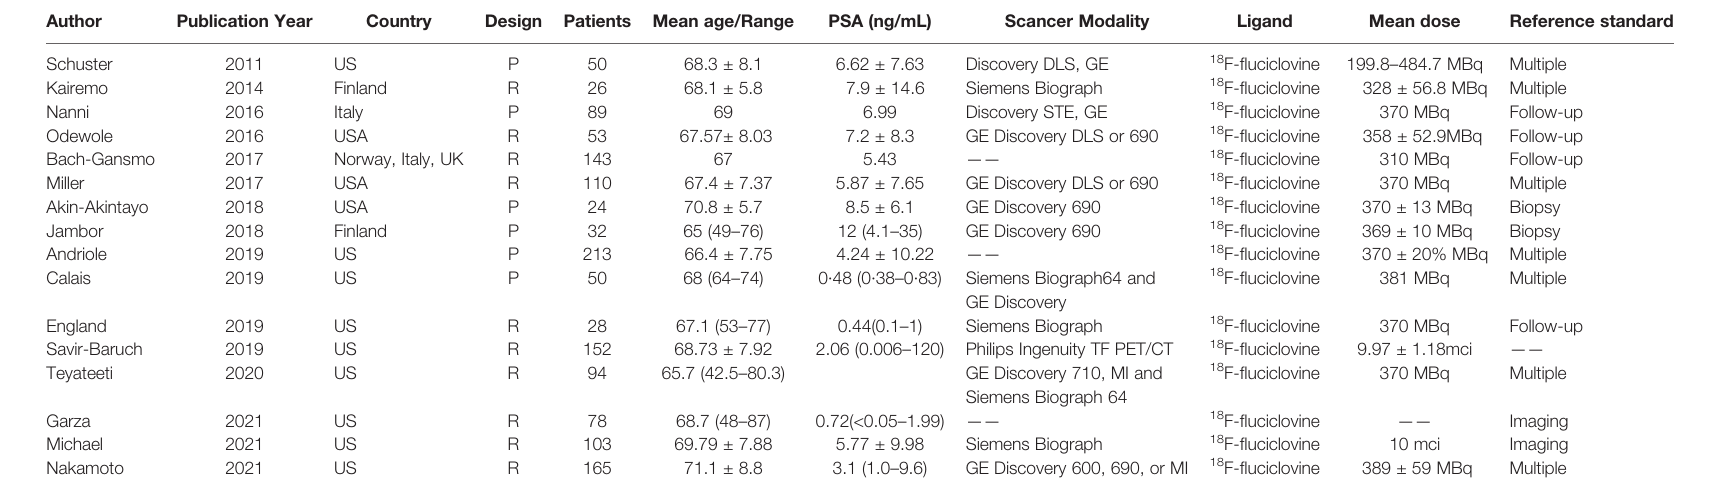
TABLE 2 | Study characteristics of 18 F- fl uciclovine PET/CT.